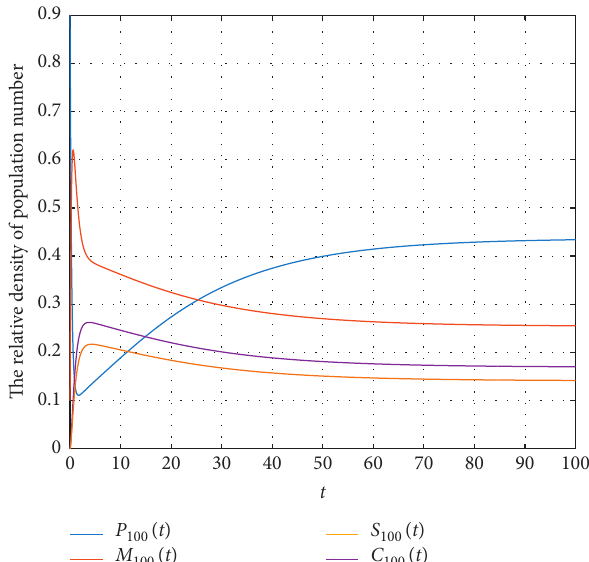
Figure 4: The time series and orbits of four states with R